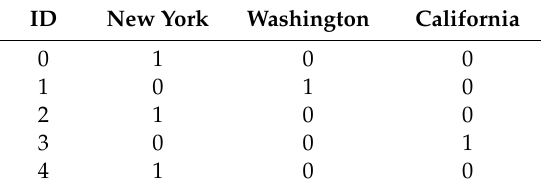
Table 4. One-hot encoding of the toy dataset.